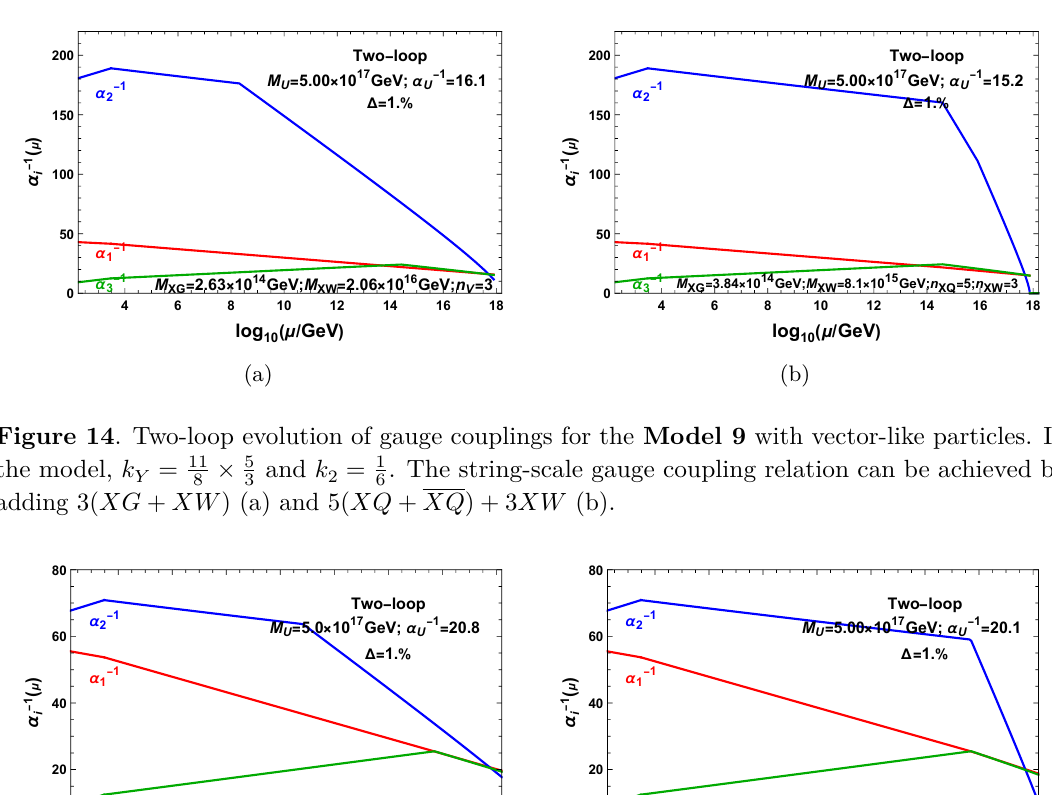
Figure 13 . Two-loop evolution of gauge couplings for the Model 8 with vector-like particles. In the model, k = 10 × 5 and k = 1 . The string-scale gauge coupling relations can be achieved by Y 2 7 3 adding 3( XG + XW ) (a) and 3( XQ + XQ ) + 3 XG (b).